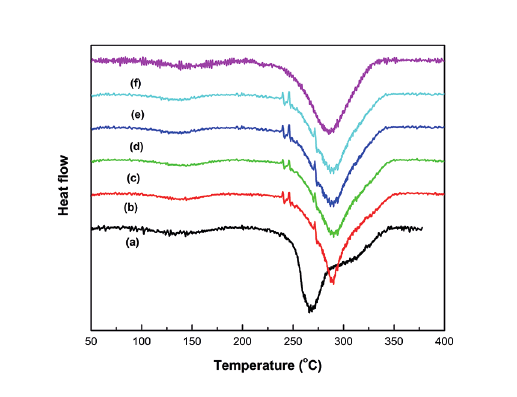
Figure 2: dTG curves of PVC polymer films containing Mn 2+ (a) pure (b) 1mol% (c) 2 mol% (d) 3 mol% (e) 4 mol% (f) 5